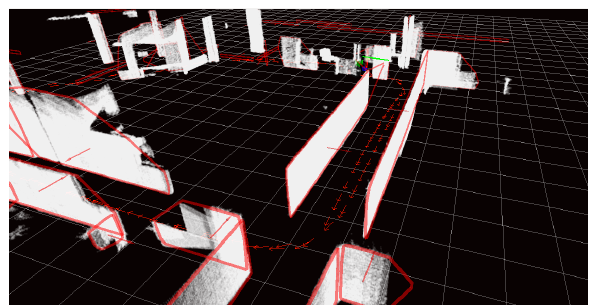
Figure 1: An example of the type of map produced by our system. Planar features are visible by the red convex hulls and red normal vectors. The small red arrows on the ground plane show the robot’s trajectory. The point clouds used to extract these measurements are shown in white and have been rendered in the map coordinate frame by making use of the optimized poses from which they were